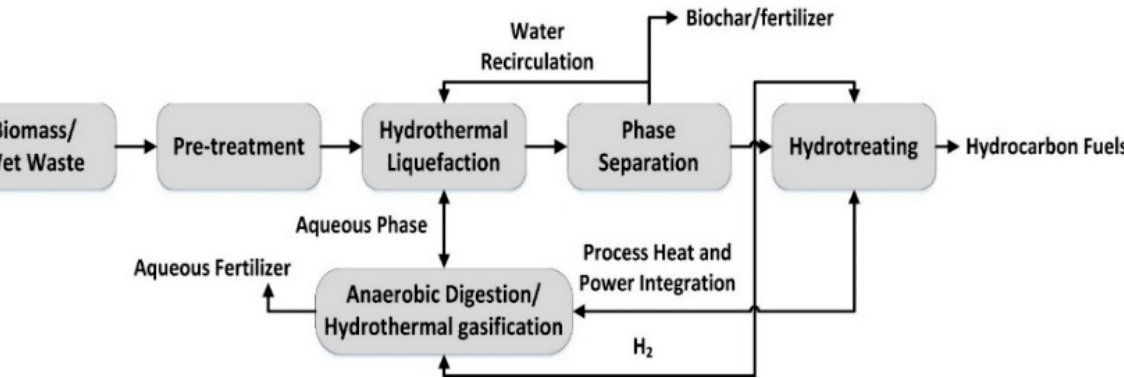
Figure 6. Process flow diagram of HTL process of lignocellulose biomass (Adapted from Gollakota et al. [67]